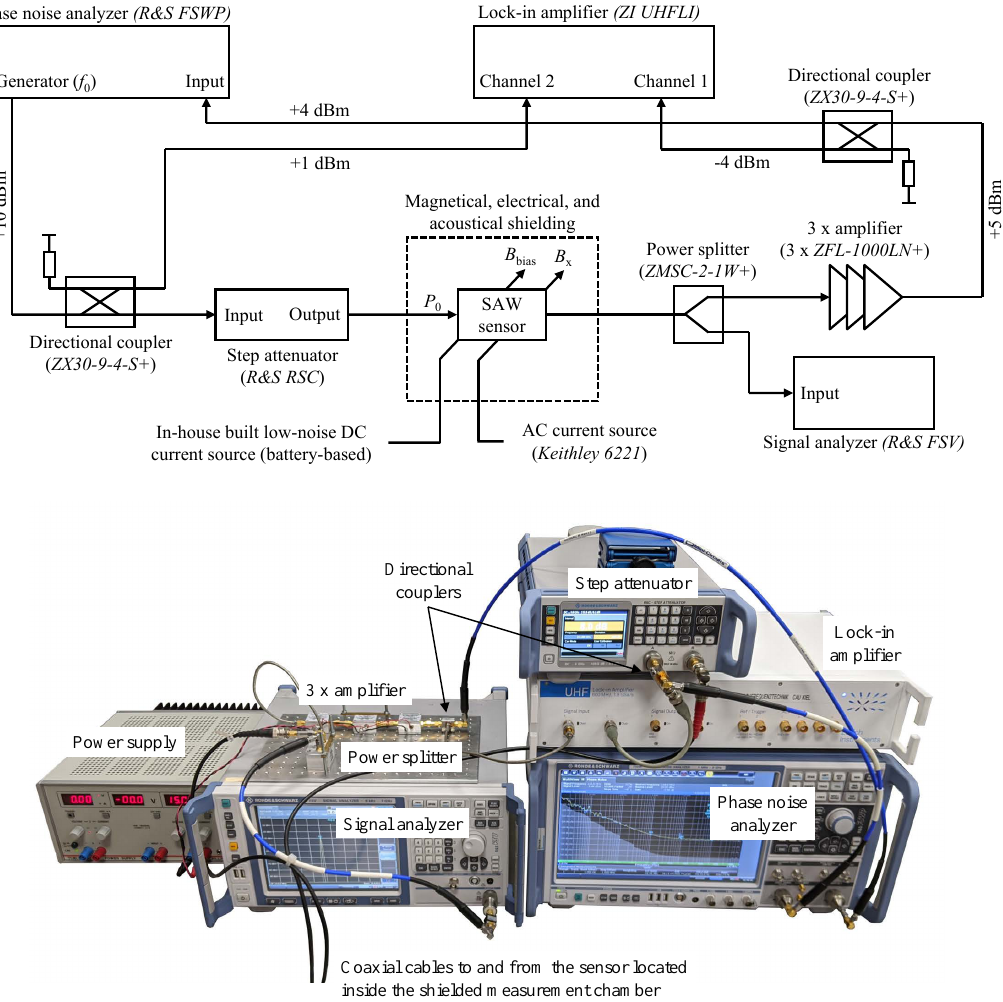
Figure 10. Block diagram ( top ) and photography ( bottom ) of the utilized system for the automatized measurement of the sensor’s phase sensitivity S PM , the phase noise S ϕ , and the insertion loss IL as a function of both the sensor’s input power P 0 as well as the magnetic bias flux density B bias